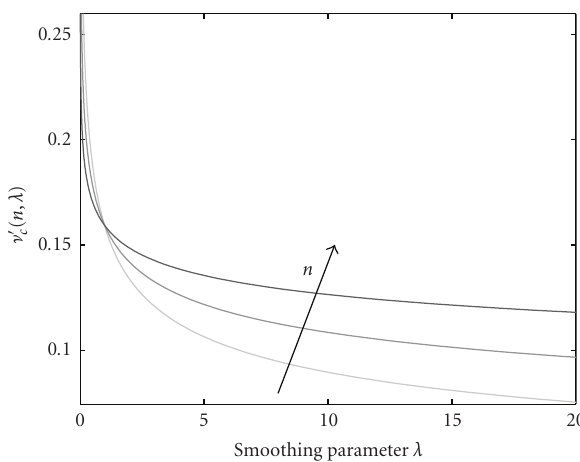
Figure 4: Dependency of the cut-o ff frequency of polynomial spline filters with the smoothing parameter λ for n = 3, 5, and 9 (black arrow indicates increasing order). ( t (cid:2) ). λ